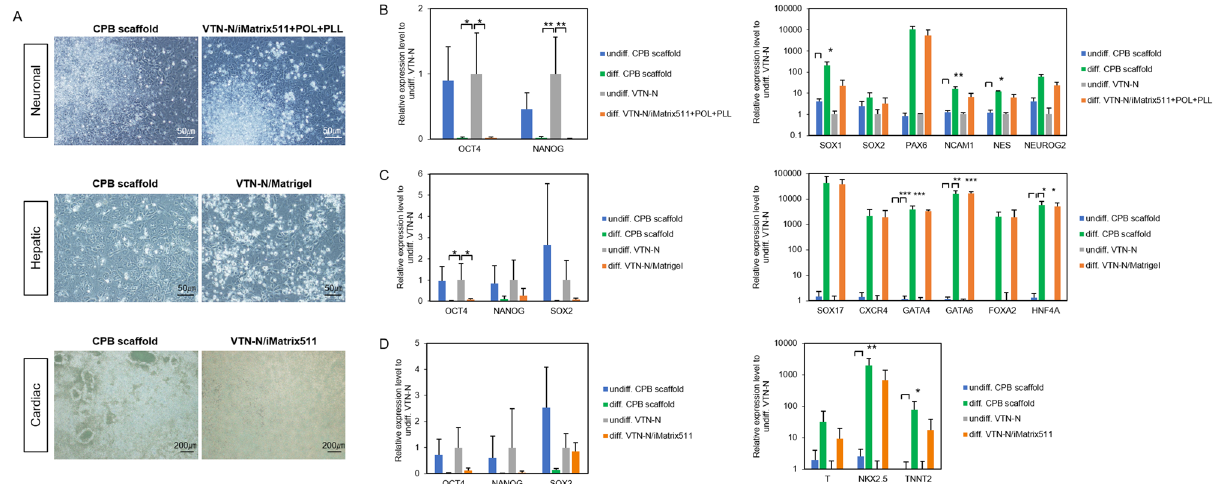
Figure 8. Differentiation of human induced pluripotent stem cells on CPB scaffold into three-germ layers. ( A ) Representative images of differentiated 253G1 cells at 6–7 days after neuronal ectoderm (top), hepatic endoderm (middle), and cardiac mesoderm (bottom) induction. Left images show the differentiated cells on CPB scaffold induced from the cells maintained on CPB scaffold more than 10 passages before differentiation induction. Right images show differentiated cells on control differentiation substrate according to each protocol from the cells maintained on the control maintenance substrate VTN-N. The control differentiation substrate was Laminin/poly-L-ornithine/poly-L-lysin (iMatrix511/POL/PLL) for neural, Matrigel for hepatic, and laminin (iMatrix-511) for cardiac differentiation. Scale bars are indicated in the images. ( B ) Expression level of undifferentiated (OCT4 and NANOG) and neural lineage (SOX1, SOX2, PAX6, NCAM1, NES, and NEUROG2) marker genes in the neuro-ectodermal differentiation. ( C ) Expression level of undifferentiated (OCT4, NANOG, and SOX2) and hepatic lineage (SOX17, CXCR4, GATA4, GATA6m FOXA2, and HNF4A) maker genes in the hepatic endoderm differentiation. ( D ) Expression level of undifferentiated (OCT4, NANOG, and SOX2) and cardiac lineage (T, NKX2.5, and TNNT2) marker genes in the cardiac mesoderm differentiation. All gene expression levels indicated were examined by RT-qPCR, and indicated as relative expression level to undifferentiated 253G1 cells cultured on VTN-N. Data are presented as mean ± SD of three independent experiments. (* P < 0.05, ** P < 0.01 and *** P < 0.001 compared to undifferentiated 253G1 cells cultured on VTN-